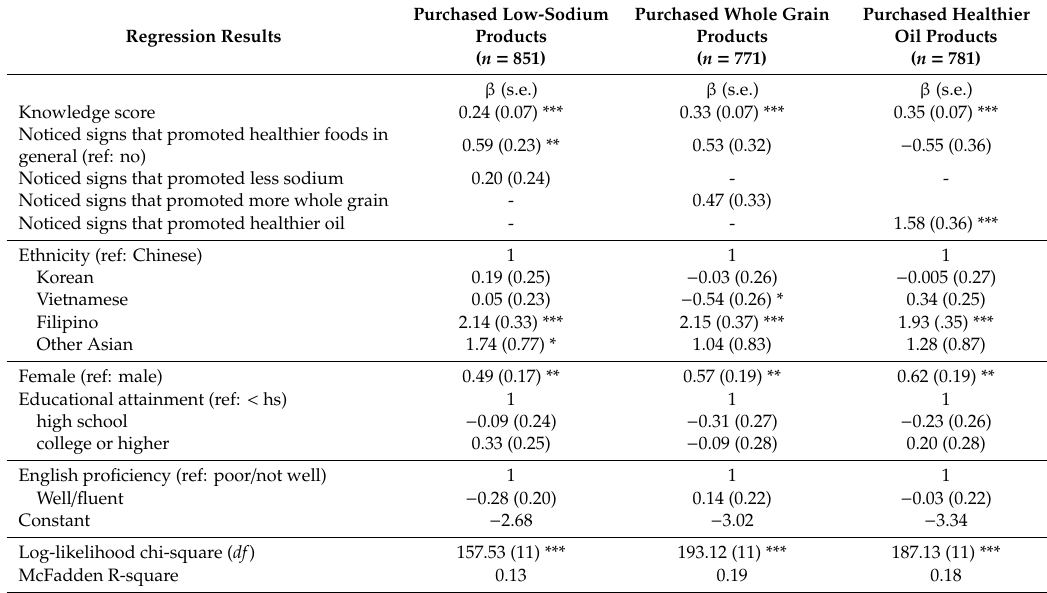
Table 6. Results of Multivariate Logistical Regression of Three Healthier Food Purchasing Behaviors at 12-Month Follow-Up